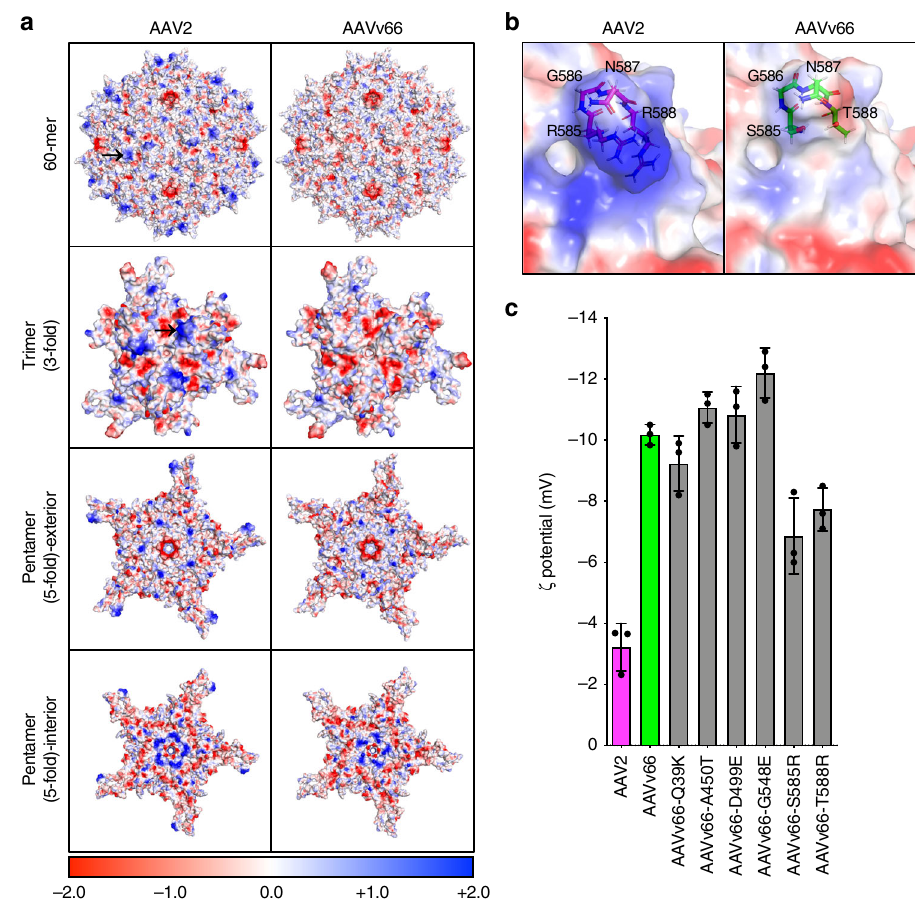
Fig. 7 Differential capsid surface electrostatics between AAV2 and AAVv66. a Surface positive (blue) and negative (red) charges are displayed for AAV2 and AAVv66 60-mer, trimer (threefold symmetry), and pentamers (exterior and interior of the fi vefold symmetry) structures. Black arrows at the AAV2 60-mer and trimer structures indicate the approximate positions of R585 and R588 at a single threefold protrusion. The color scale bar represents the electrostatic potential on the solvent accessible surface in kT/e units. b Zoom-in of amino acid residues at 585 – 588 of AAV2 and AAVv66. c Bar graphs of the zeta potentials of puri fi ed vectors as measured by a Zetasizer. Values represent mean ± SD, n =